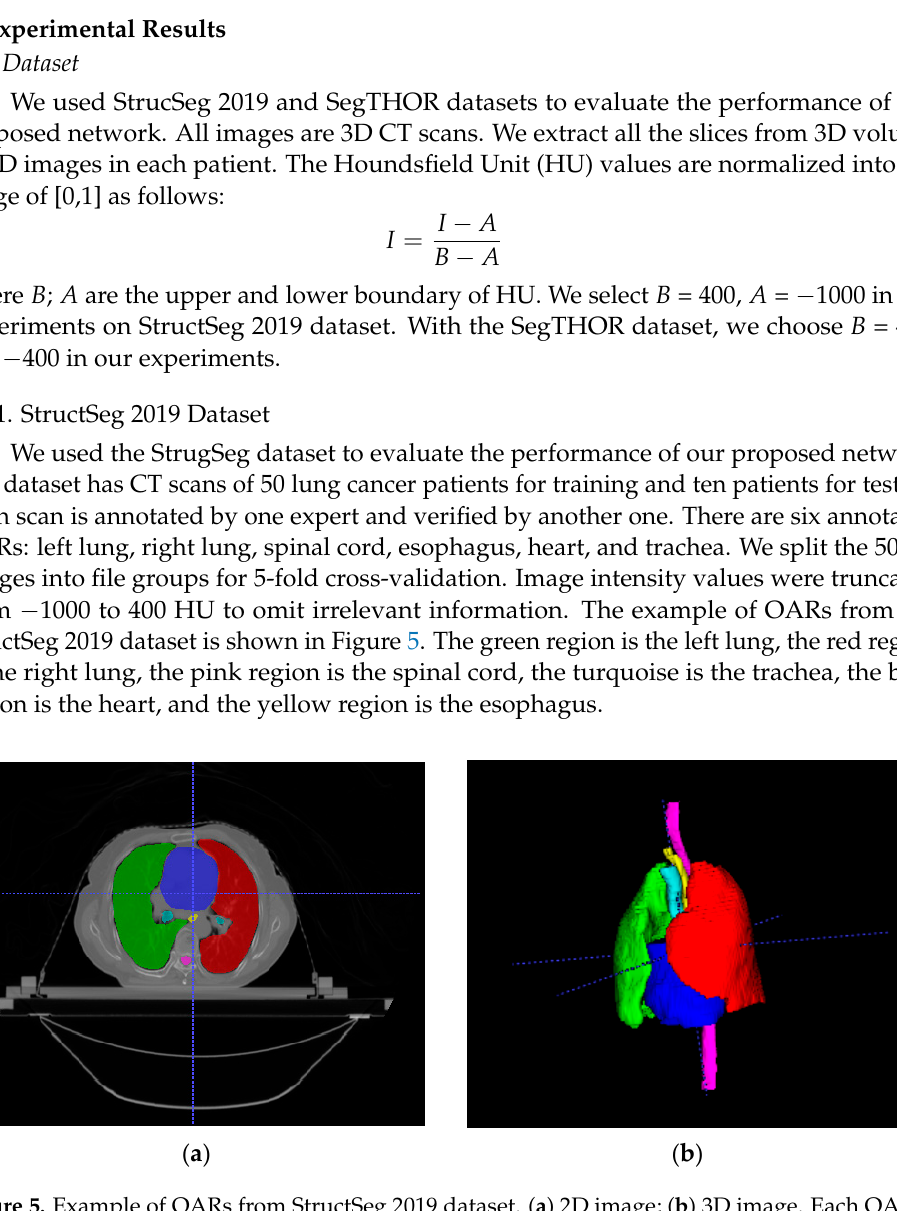
Figure 6. Example of OARs from SegTHOR ISBI 2019 dataset. ( a ) 2D image; ( b ) 3D image. Each OAR is shown in a different color. The green region is the heart; the yellow region is the esophagus; the blue region is the trachea; the red region is the aorta.